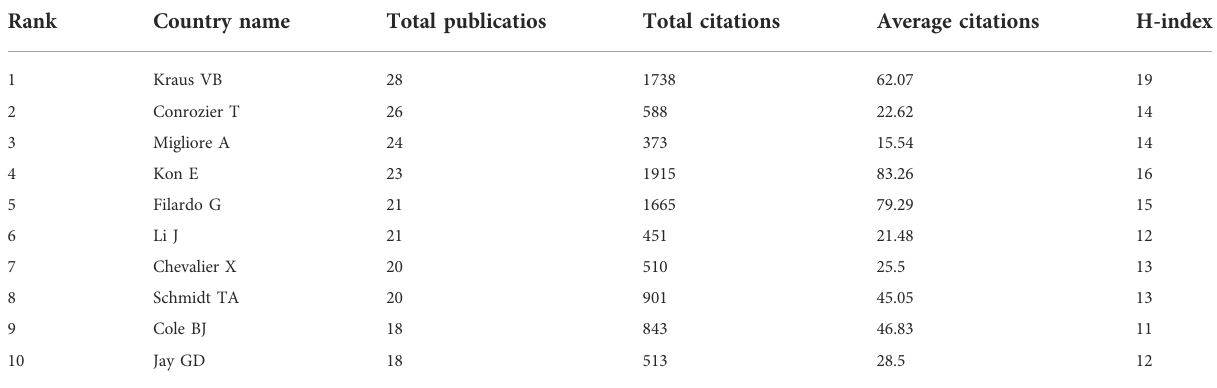
TABLE 3 The top ten authors that contributed publications on HA for the treatment of osteoarthritis.